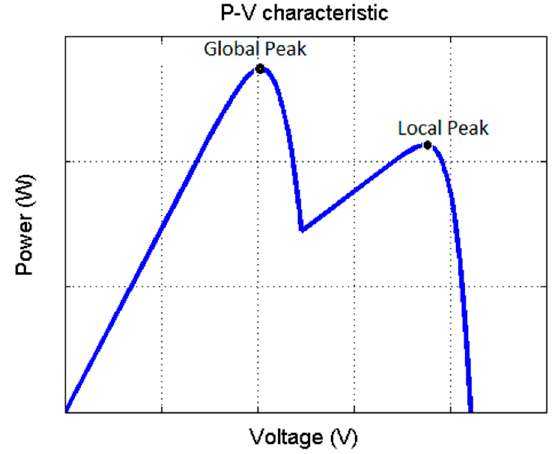
Figure 3. P-V characteristics of photovoltaic string under partial shading.